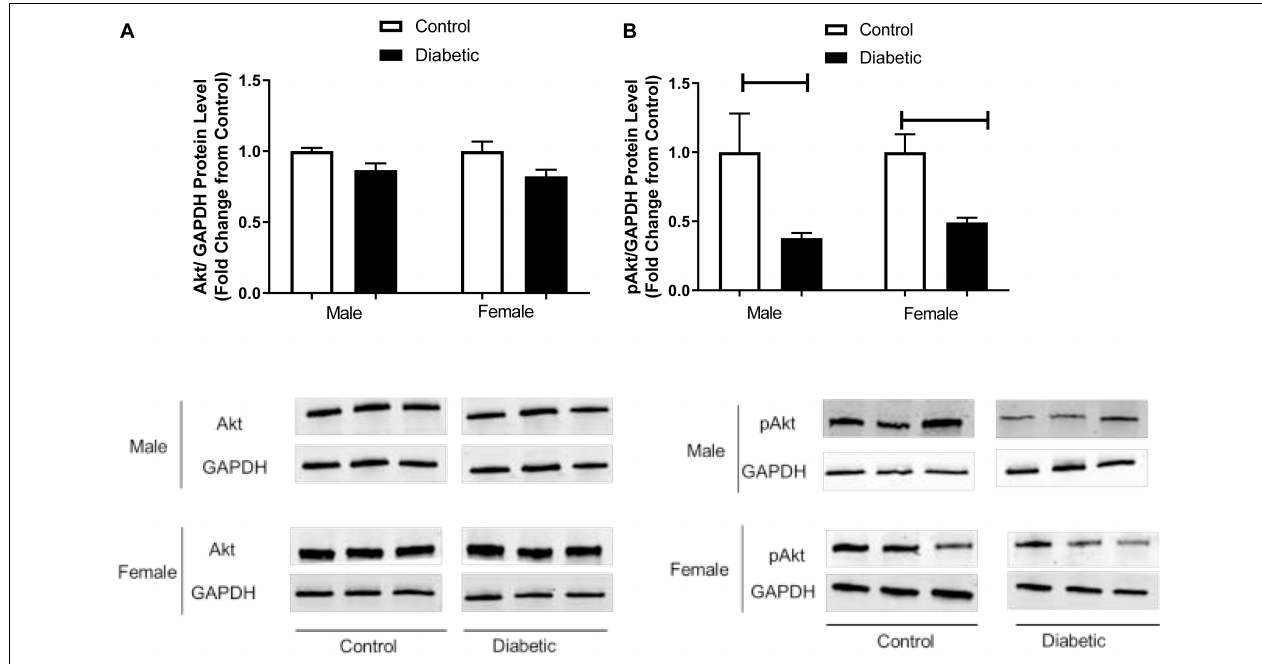
FIGURE 8 | Western blot analysis of Akt and pAkt expression in control and UCD-T2DM rat aorta. Protein levels of aortic (A) total V-akt murine thymoma viral oncogene homolog-2 (Akt) and (B) phosphorylated V-akt murine thymoma viral oncogene homolog-2 (pAkt) from the samples of male and female control and diabetic rats. Akt (A) and pAkt (B) were quantified by densitometry and normalized to corresponding GAPDH. Each bar represents the mean ± SEM of values obtained from n = 4–5 animals per group. To show representative bands, images from different parts of the same gel have been juxtaposed, indicated by white dividing lines. Capped lines indicate significant differences between two groups ( p < 0.05), as analyzed by unpaired Student’s t